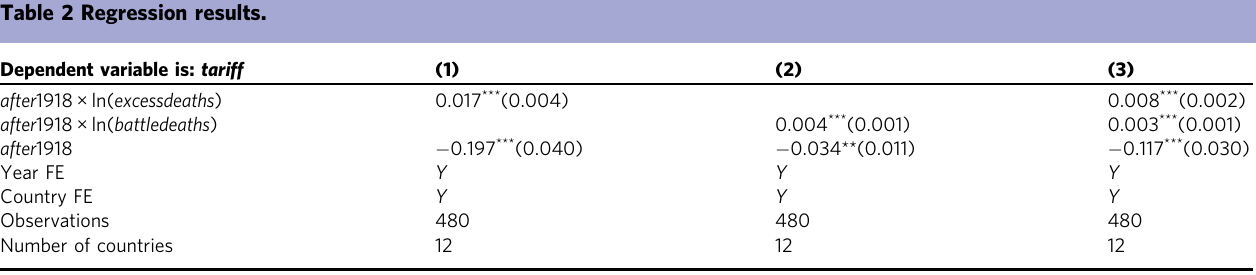
Fig. 3 Average tariffs in the decades 1910s, 1920s and 1930s. The maps show standardized tariff intervals, in order to make the decades comparable to one another. Panel ( A ) shows the average tariffs for 1910 – 1919, Panel ( B ) shows the average tariffs for the interval 1920 – 1929, and Panel ( C ) shows the average tariffs for 1930 – 1939. Table 2 Regression